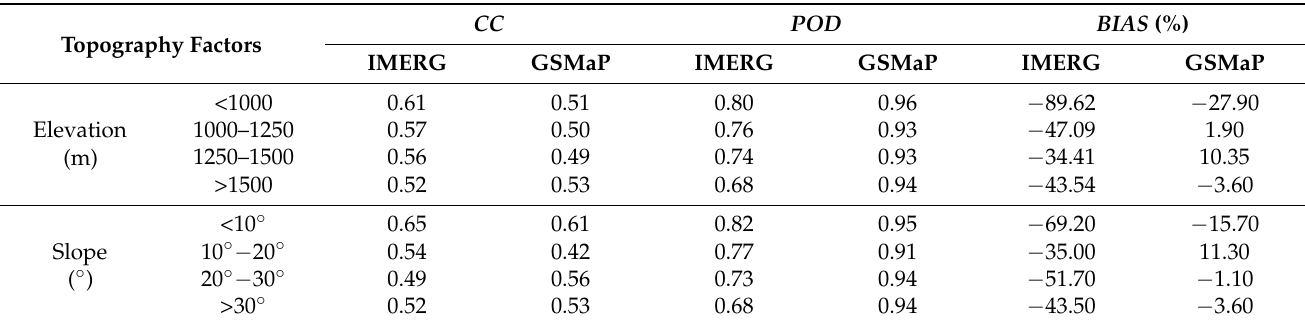
Table 7. Summary of dependence of the performance of rainfall products on topography factors (elevation and slope).